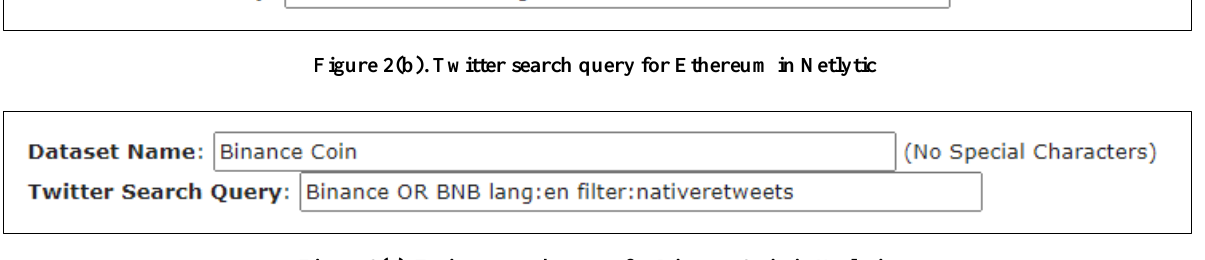
Figure 2(c). Twitter search query for Binance Coin in